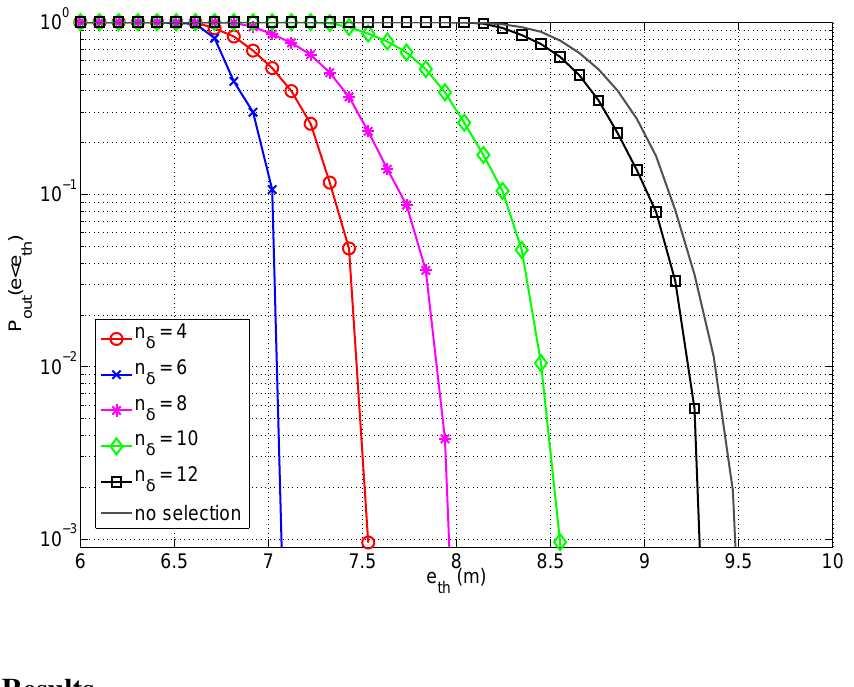
Figure 7. Outage probability ( N 1 = 18 ).